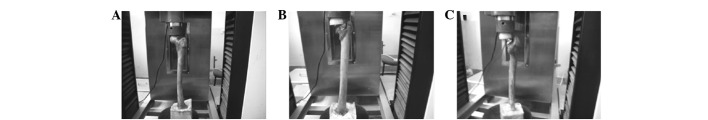
Load relaxation experiment images of the specimens in three groups. (A) Load relaxation experiment image of the control. (B) Load relaxation experiment image of the traditional type of prosthesis implantation group. (C) Load relaxation experiment image of the preservation of femoral neck prosthesis implantation group.